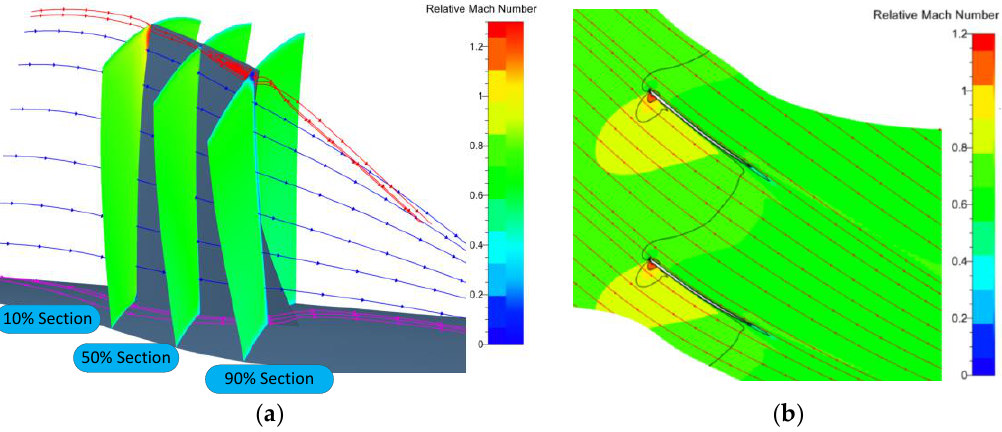
Figure 9. Flow Field Details of the Air-Driven Fan Rotor. ( a ) Mach number contour of the cross stream at different sections; ( b ) Mach number contour of at a 90% span.